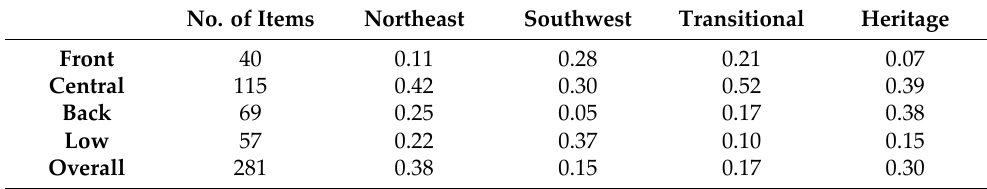
Table 4. Vowel quality proportions by group (open syllable mid-vowel contrasts).